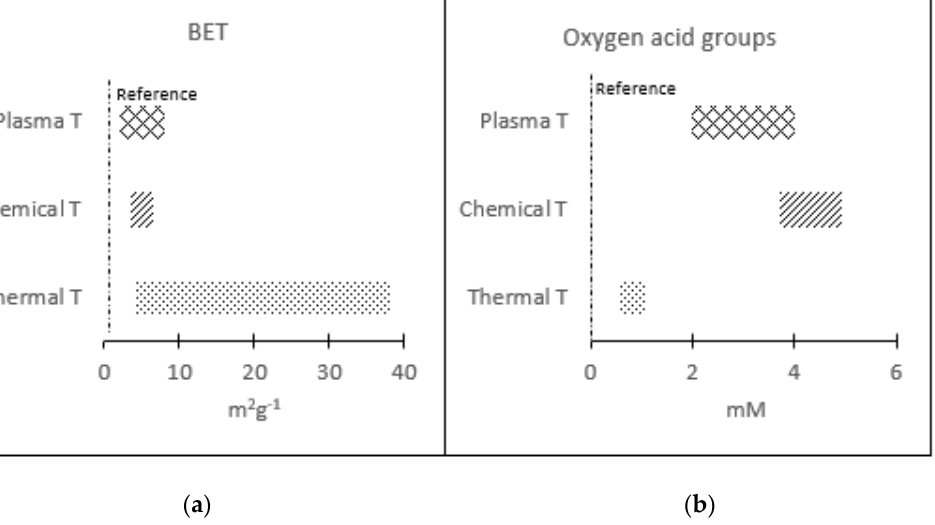
Figure 4. Comparison of different treatments considering ( a ) surface area and ( b ) oxygenated groups. Table 5. Selected samples for the electrochemical